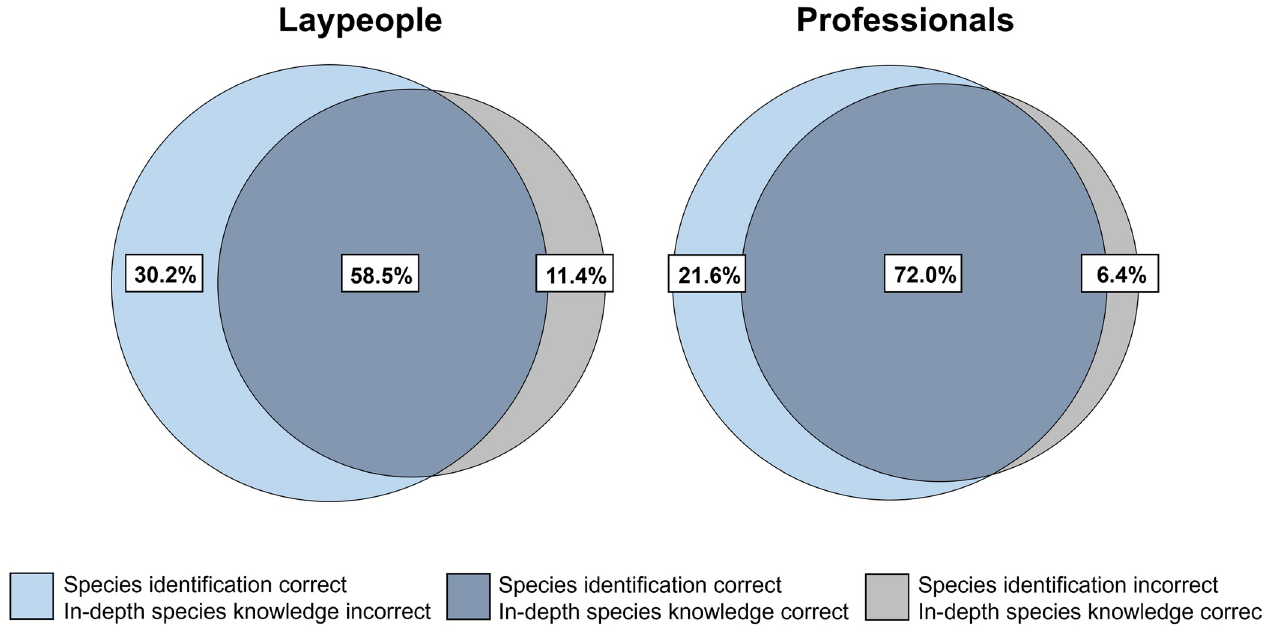
Fig 2. Venn diagrams showing the overlap in species identification and in-depth knowledge in both laypeople and professionals for the four themes combined.